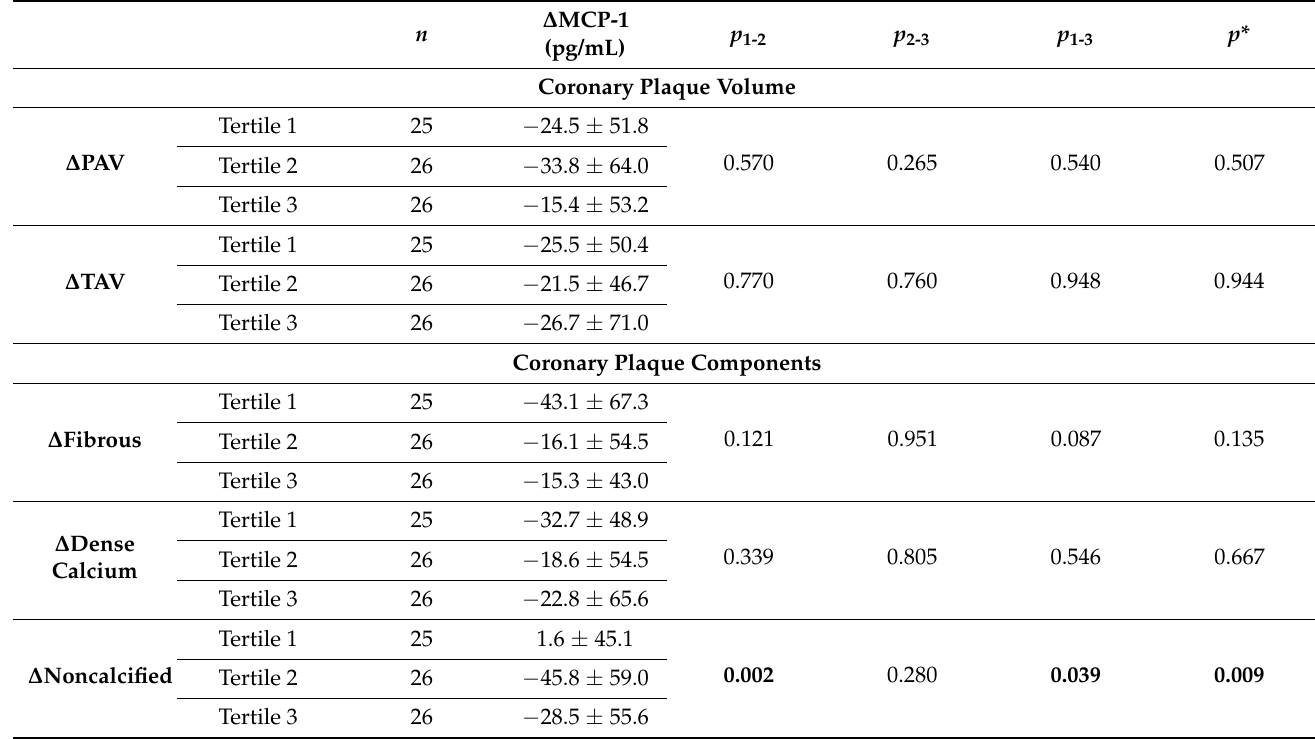
Table 8. Changes ( ∆ ) in MCP-1 plasma concentration within tertiles of changes in the atherosclerotic plaque volume and composition. P1-2 values represent differences between tertile 1 and tertile 2. P2-3 values represent differences between tertile 2 and tertile 3. P1-3 values represent differences between tertile 1 and tertile 3. P1-2, p2-3, and p1-3 values were obtained using a t -test to compare means. p * values were obtained using one-way ANOVA comparing intergroup differences. Statistically significant p -values are marked in